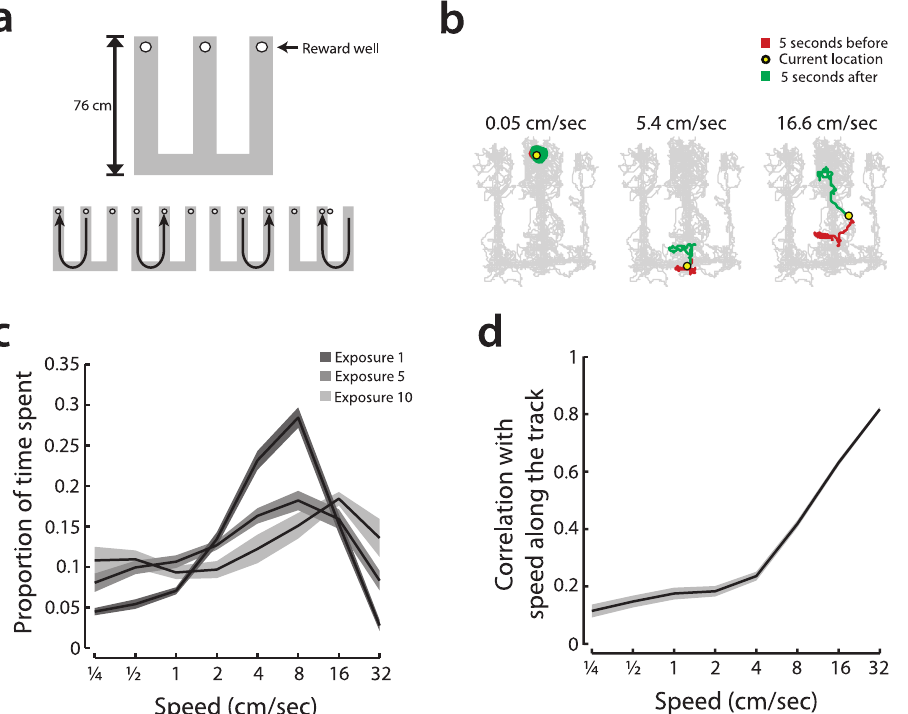
Figure 1. Learning corresponds with a decrease in intermediate-speed exploratory behaviors. a, (top) Rats were introduced to a novel W shaped environment where they learned to perform a spatial alternation task over multiple 15 minute exposures. (bottom) Animals were rewarded at the ends of each arm when they performed the correct sequence of trajectories: from center arm to left to center to right to center… b, Rat behavior was monitored using head-mounted infrared diodes tracked with an overhead camera, and smoothed speed was extracted from this data. Three examples of extracted speed also show the surrounding behavioral trajectory over 10 seconds in slow, medium, and fast cases. c, The head movement speed distributions for exposures 1, 5, and 10 to an initially novel W-track. Means are shown with solid lines and standard errors with shaded regions. d, Correlation between speed, measured in two dimensions, and linear speed along the axis of the track. Lower correlations at intermediate speeds are consistent with exploratory behavior.